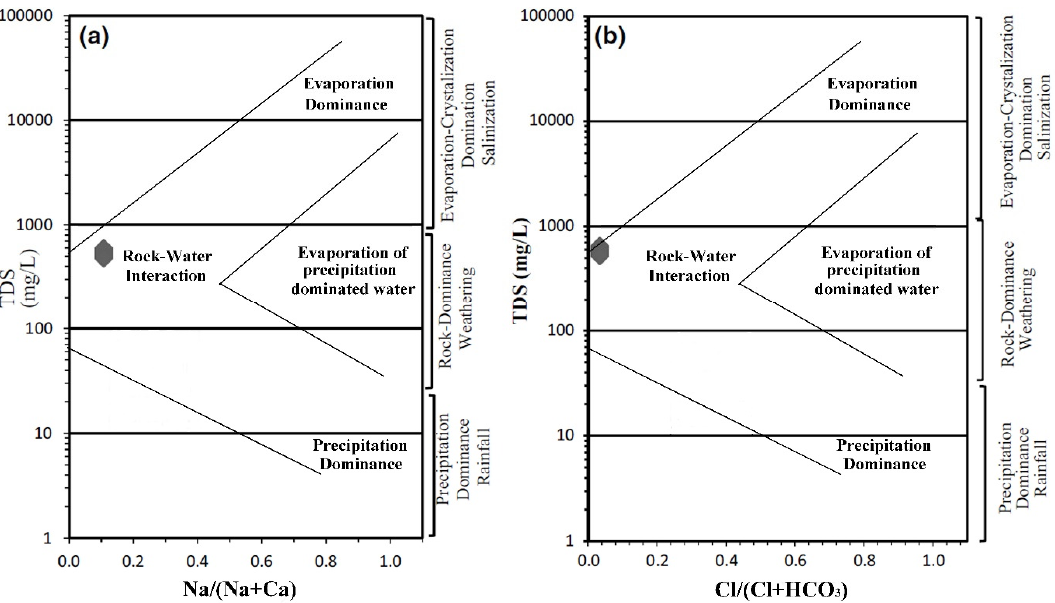
Figure 7. Gibbs plot a : TDS vs Na / (Na + Ca), and b : TDS vs Cl / (Cl + HCO 3 ) showing major processes controlling water chemistry of the Ridracoli reservoir water.